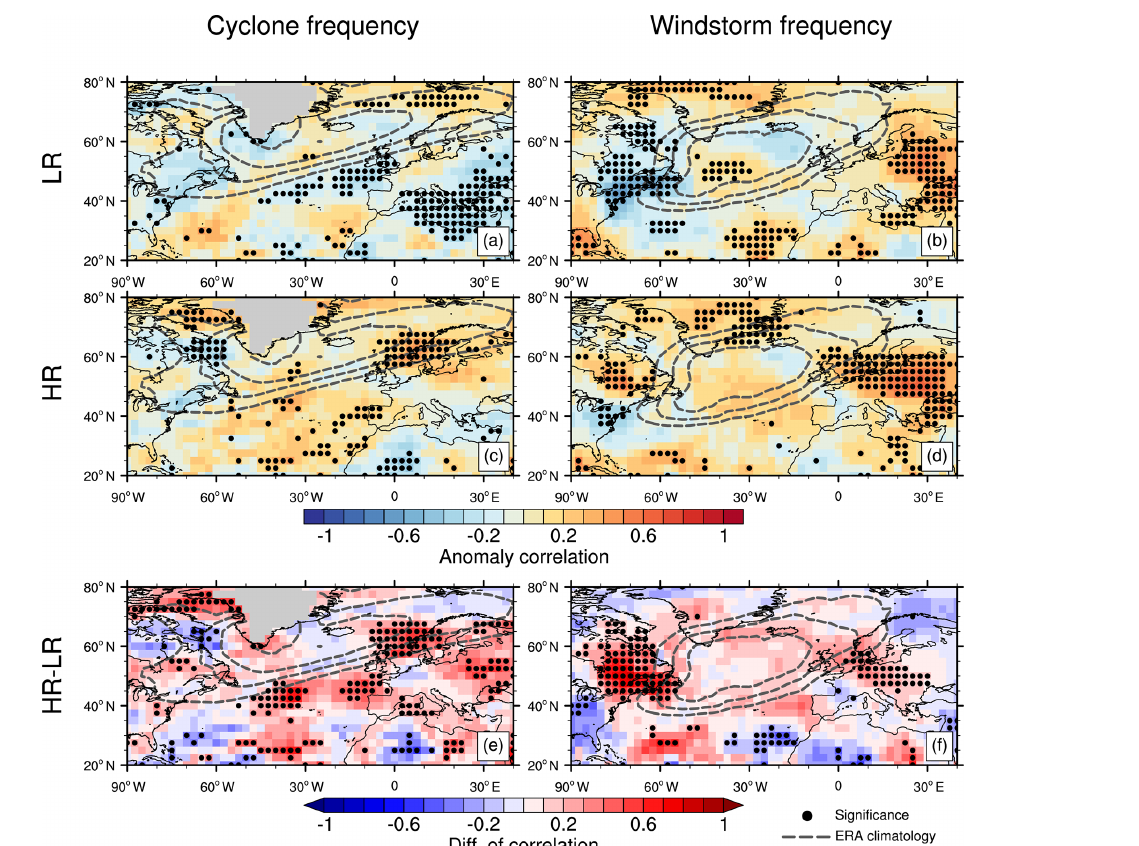
Figure 6. Same as Fig. 5 but for the cyclone frequency (a, c, e) and the windstorm frequency (b, d, f)